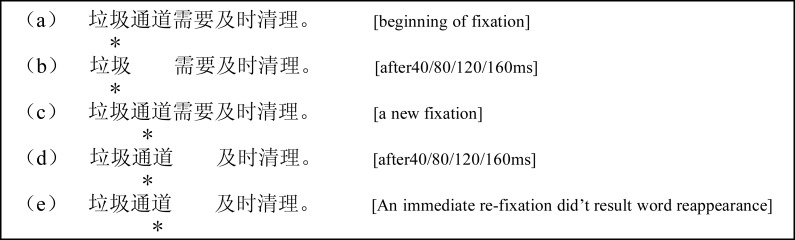
Examples of the four word n + 1 disappearance conditions.The asterisk indicates a fixation location.